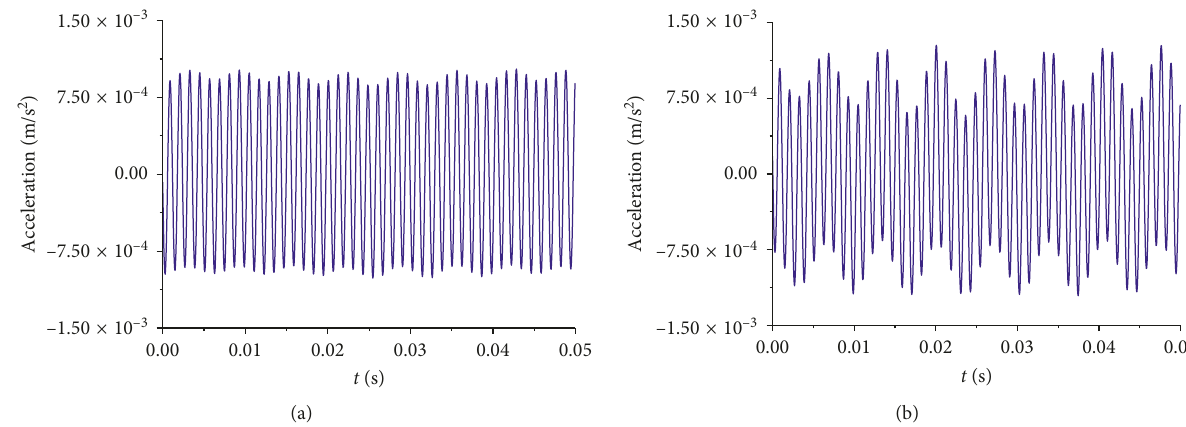
Figure 6: Time domain diagram of vertical vibration acceleration of car body: (a) health gear (b) the crack length of the pinion is 4mm.